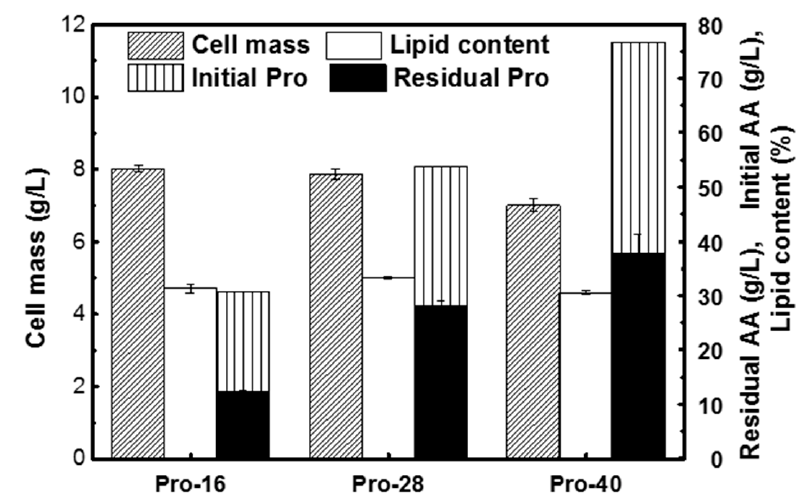
Figure 3. Results of lipid production on Pro at different initial concentrations. Cultures were performed at 30 °C and 200 rpm for 108 h.